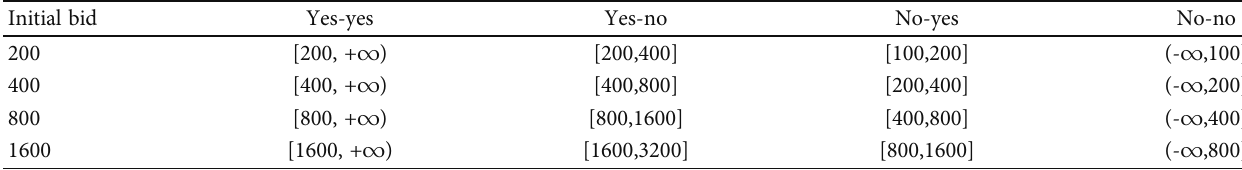
Table 3: WTP intervals for four initial bids (source: authors).